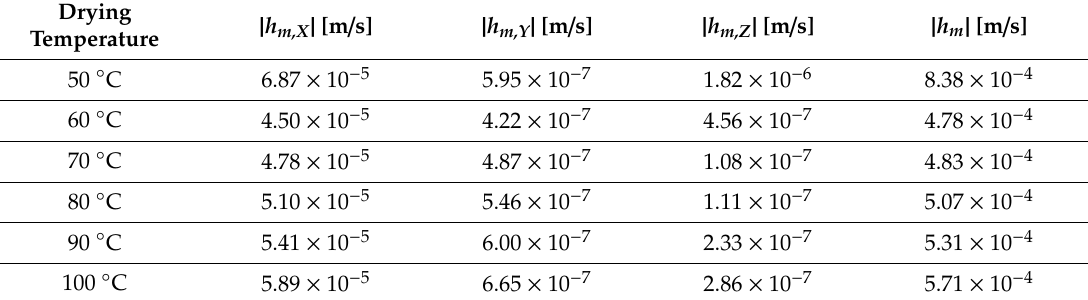
Table 3. Convective mass transfer coe ffi cients obtained with the simulations.